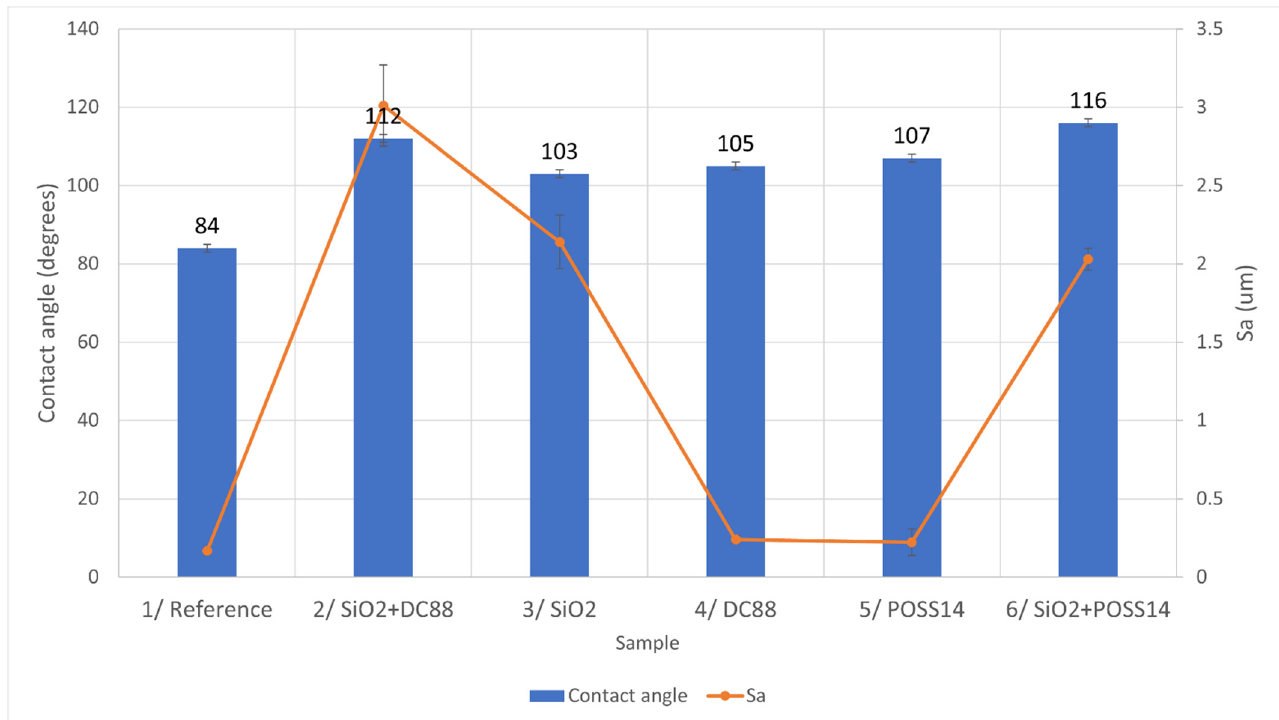
Figure 5. The relationship between roughness of the samples and their wettability.